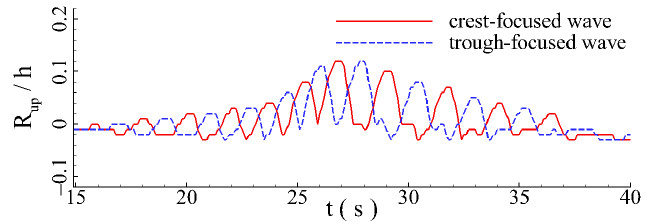
Figure 15. Comparisons of the wave runup heights.